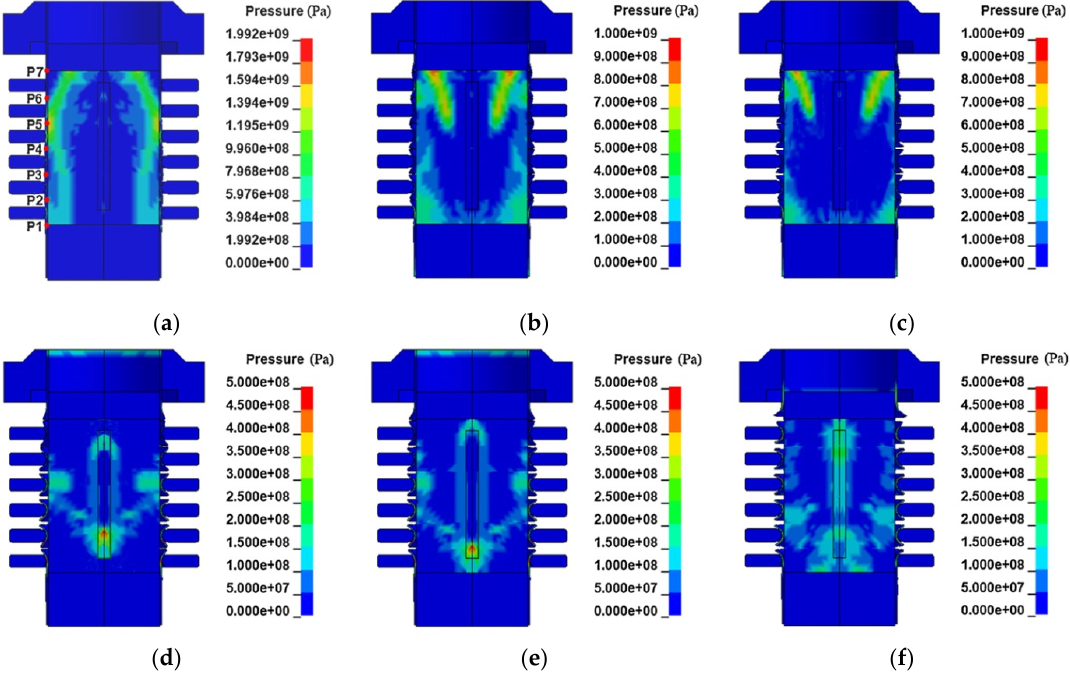
Figure 3. Pressure contour and breaking sequence of the Barrel Conductor at: ( a ) 26 μ s ( b ) 35 μ s; ( c ) 39 μ s; ( d ) 42 μ s; ( e ) 50 μ s and ( f ) 70 μ